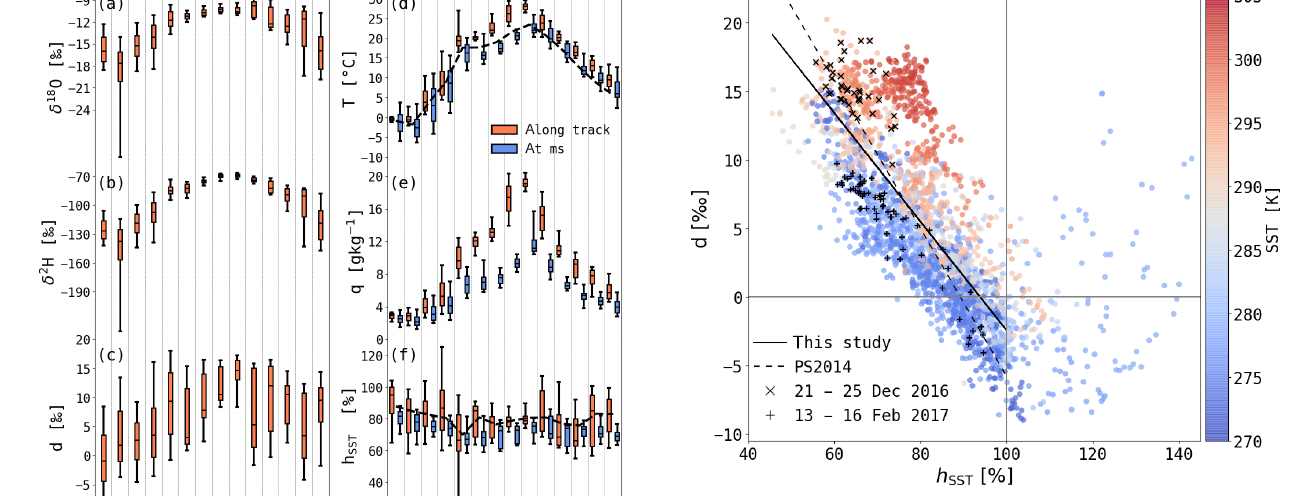
Figure 7. Scatter plot of d versus h SST coloured by SST. The lin- ear fit to all points with h SST < 100% (black line) has a Pearson correlation coefficient of − 0 . 73 with the following fitting function: d(h SST ) = − 0 . 4‰% − 1 · h SST + 36 . 8‰. The dashed line shows the linear relationship between d and h SST from Pfahl and Sodemann (2014). Two time periods with low h SST are marked: 21–25 De- cember 2016 ( × ) and 13–16 February 2017 ( +